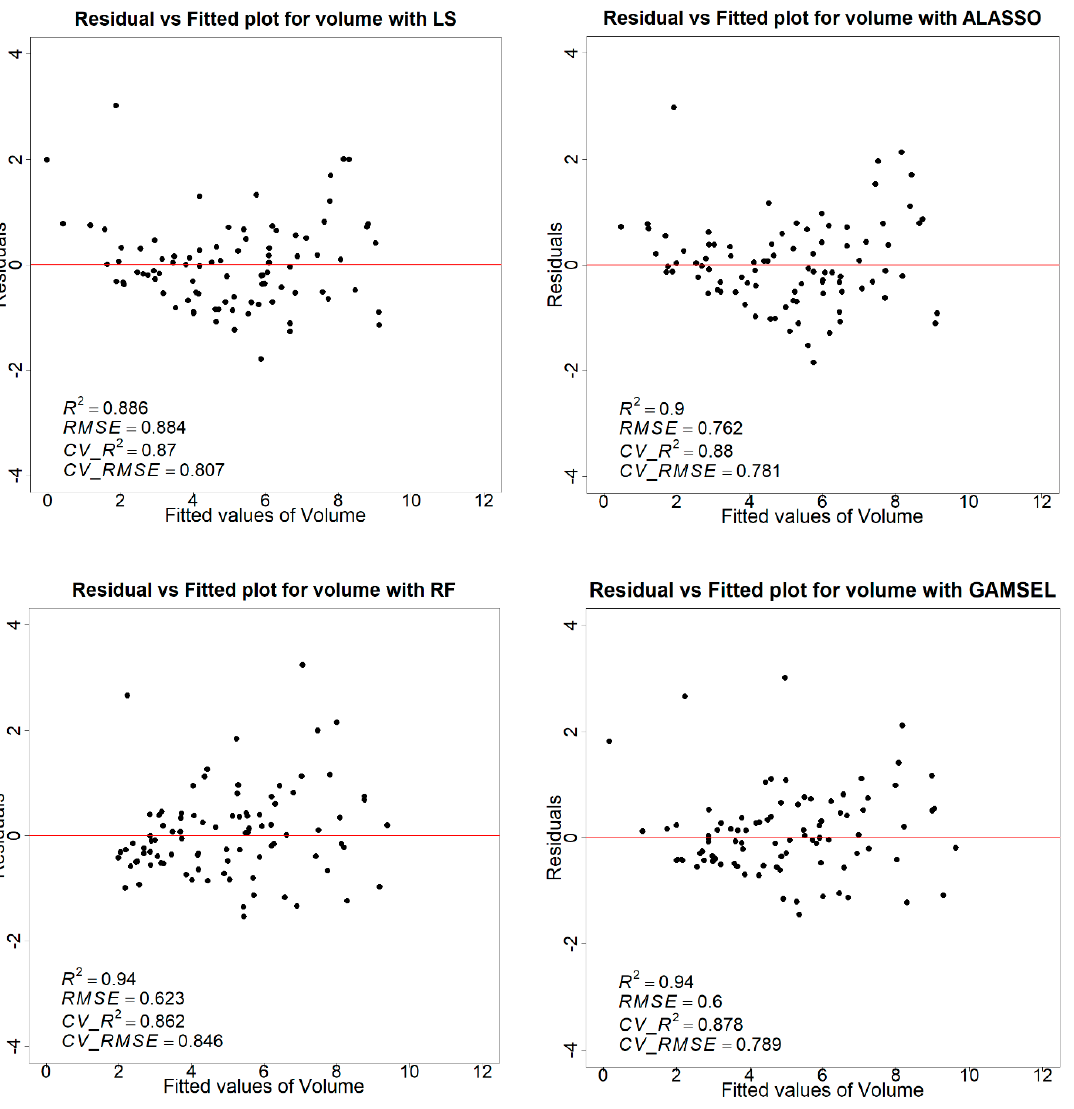
Figure A1. Each panel shows the residual vs. fitted plot for volume with LS, ALASSO, RF, and GAMSEL models. R 2 and RMSE are the model accuracy before cross-validation, and CV_R 2 and CV RMSE show the model accuracy result of nine-fold cross-validation.